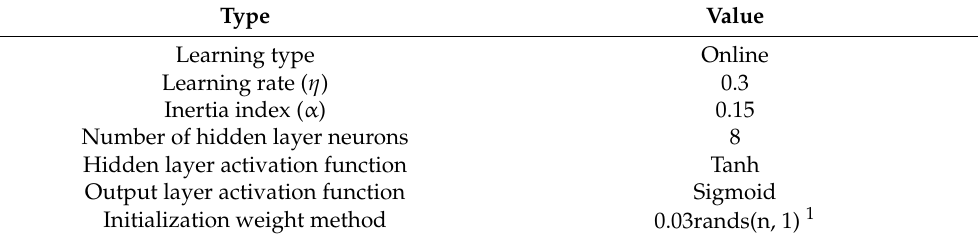
Table 1. Parameters of neural network